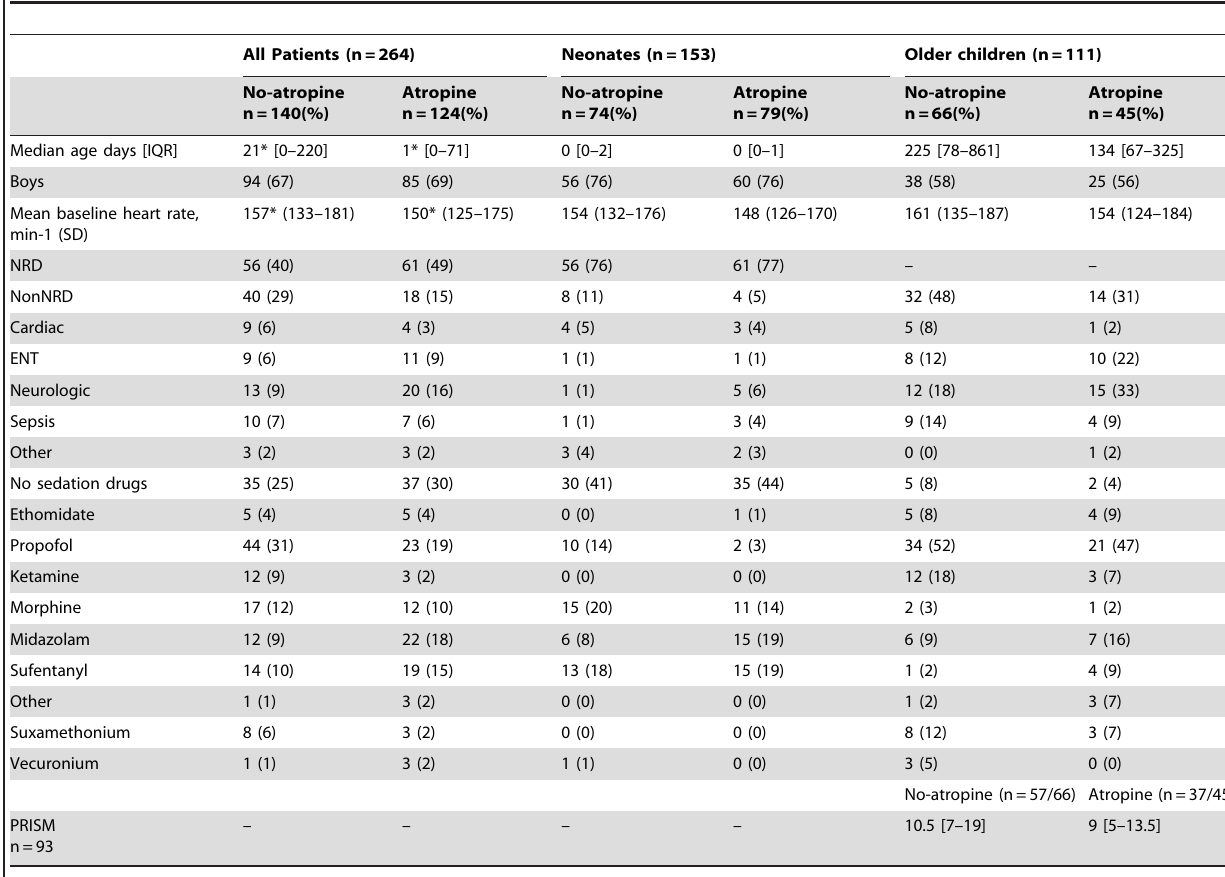
Table 1. Population characteristics for all patients and the two age sub-groups of neonates and older